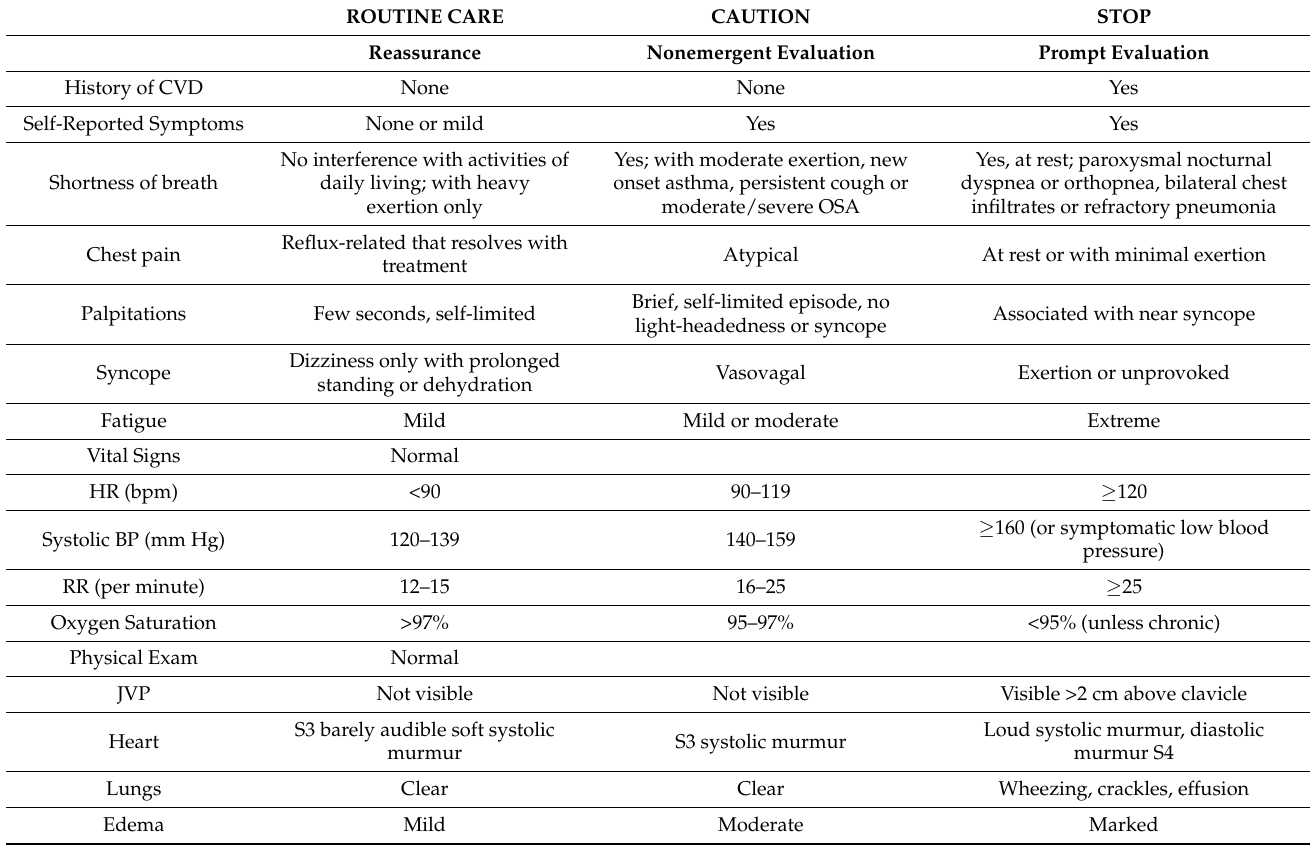
Table 1. How to differentiate common signs and symptoms of normal pregnancy versus those that are abnormal and indicative of underlying cardiac disease. ROUTINE CARE CAUTION STOP Nonemergent